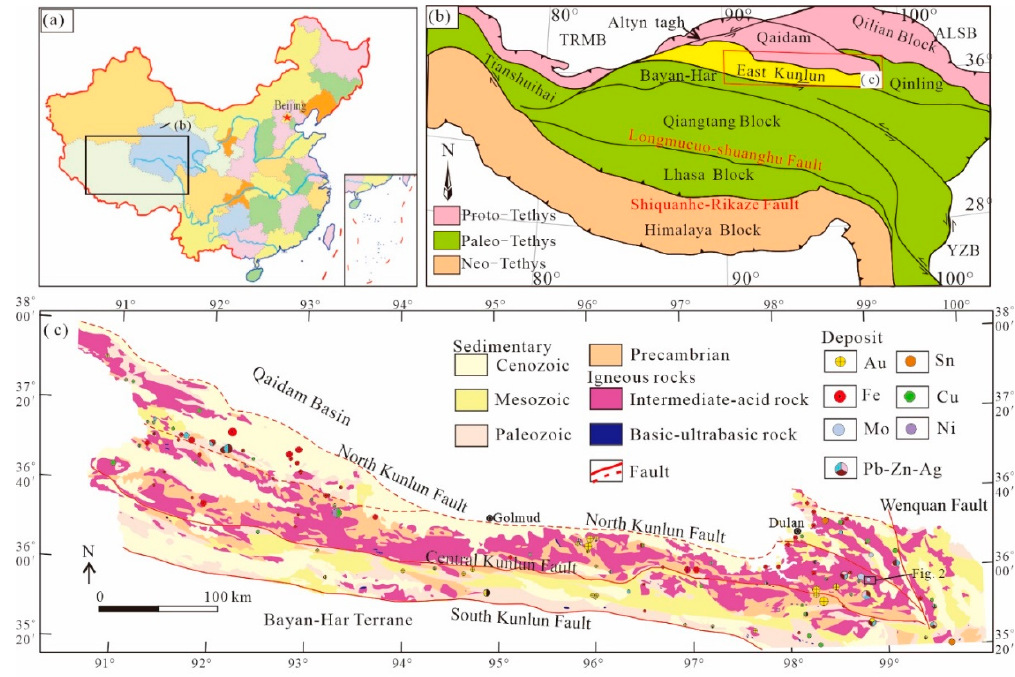
Figure 1. Regional geological map of the East Kunlun Orogenic Belt (EKOB). ( a ) The location of EKOB in the China; ( b ) the geotectonic units of EKOB in the Tibetan Plateau; ( c ) simplified geological map in EKOB (modified from Xia et al. [9]).